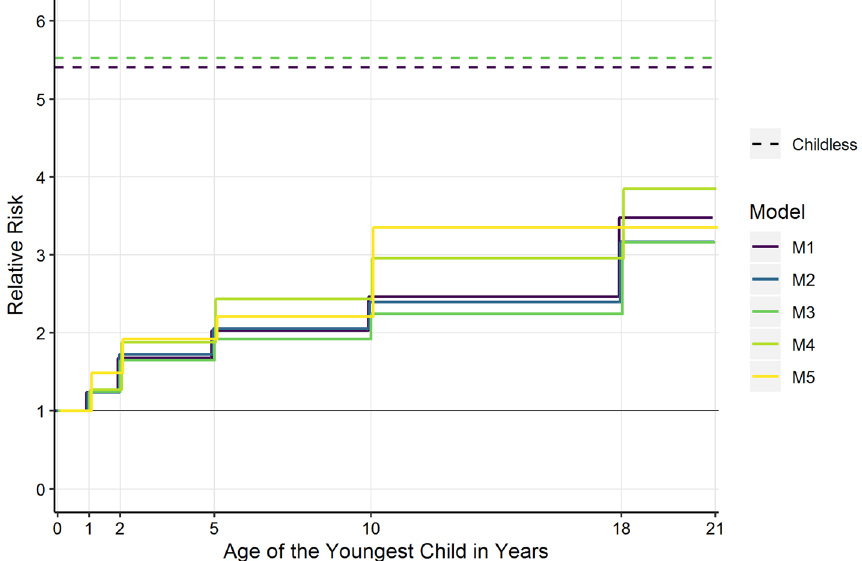
Fig. 1 Models 1–5 (women): relative risk of dying by the age of the youngest